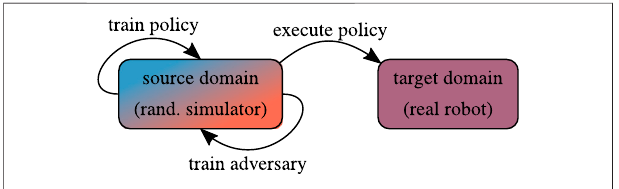
FIGURE6| Conceptual illustration ofadversarialdomain